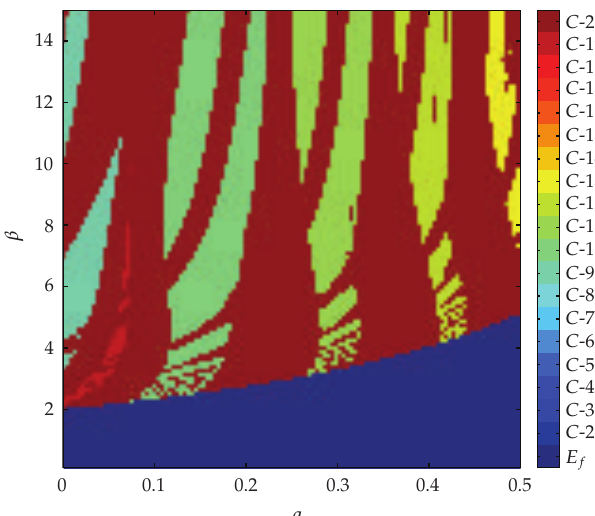
Figure 8: Two-dimensional bifurcation diagram in the parameter plane (cid:2) a,β (cid:3) for and i.c. x 0 (cid:9) 1 . 3, m 0 (cid:9) − 1 w (cid:9) 1. The other parameter values as in Figure 0